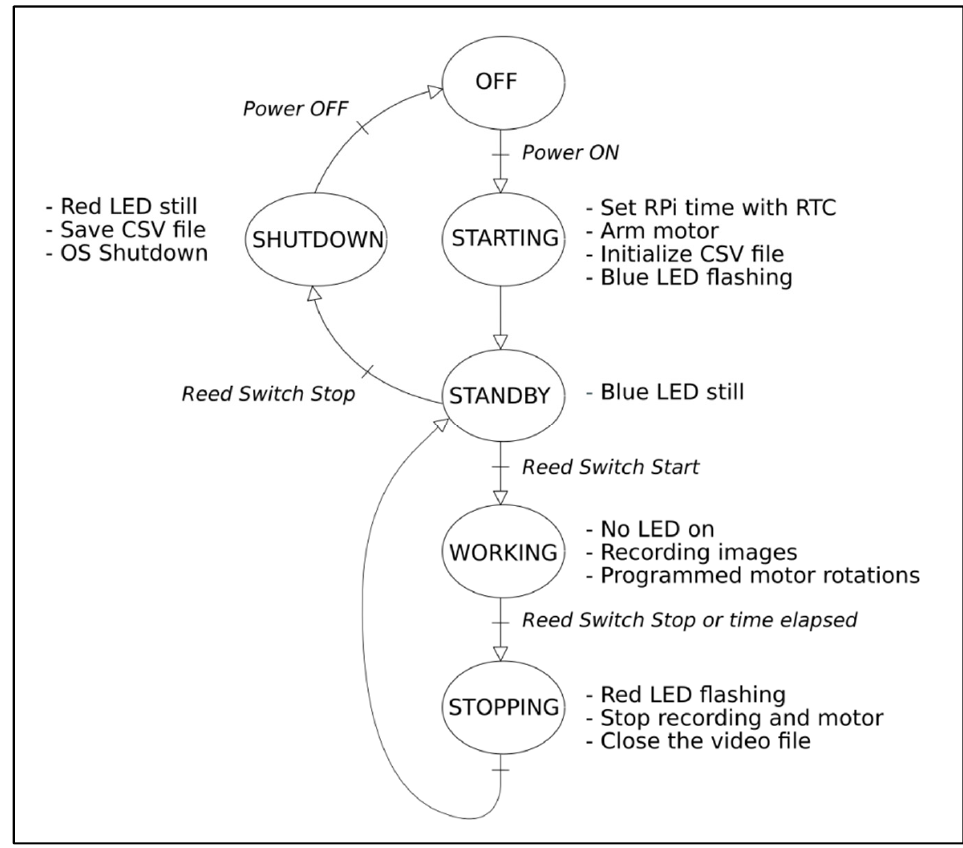
Figure 8. Flowchart of the recording process.